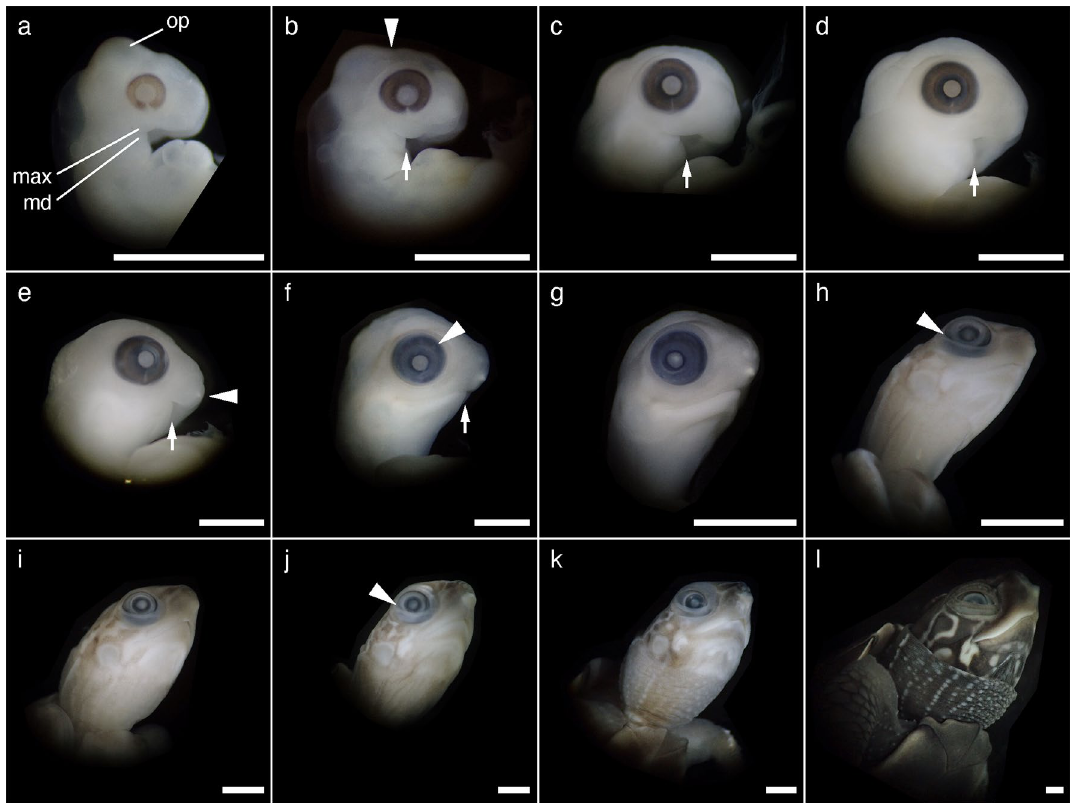
Figure 3. Formations of eye, mandible, and the surrounding structures at stages 13–24 of Mauremys reevesii . The arrows indicate the anterior end of maxillary process. ( a ) Stage 13. ( b ) Stage 14. The triangle points to the anterior end of the occipital protuberance. ( c ) Stage 15. ( d ) Stage 16. ( e ) Stage 17. The triangle points to the caruncle. ( f ) Stage 18. The triangle points to one of the scleral papillae. ( g ) Stage 19. ( h ) Stage 20. The triangle points to the lower eyelid reaching the scleral papillae. ( i ) Stage 21. ( j ) Stage 22. The triangle points to the lower eyelid reaching outer margin of the iris. ( k ) Stage 23. ( l ) Stage 24. op, the occipital protuberance; max, maxillary process; md, mandibular process. The scale bar is 2.5